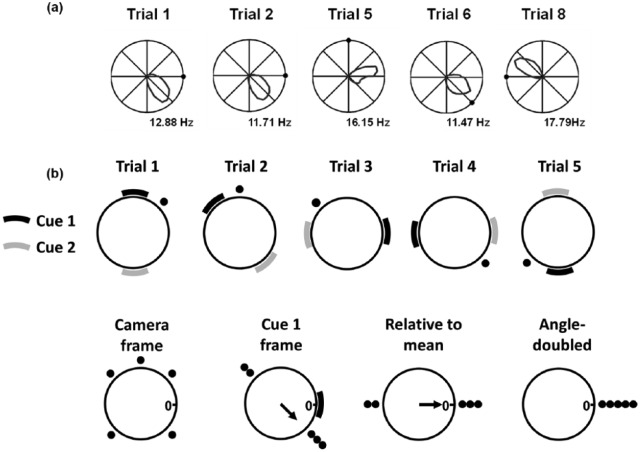
Tuning curve analysis. (a) Example of the tuning curve derived from a
single PoS HD neuron in a series of recording trials, selected from a
12-trial session. The plots show firing rate as a function of HD,
normalised to the peak rate (shown). (b) Schematic from a hypothetical
set of trials showing how data were transformed into a common reference
frame to allow population comparisons. The original reference frame was
that of the room-fixed camera: the top row shows an idealised trial in
which the cell consistently rotated its firing with the cue pair, but
was aligned relative to Cue 1 on trials 1, 2 and 5 and 180° away from it
on trials 3 and 4. The bottom row shows these data expressed in the
different reference frames: in the camera frame, the firing direction is
scattered; relative to Cue 1, it is bipolar with three trials in one
direction and two in the opposing direction; relative to the session
mean (arrow), the bulk of the firing is now aligned to zero, and after
angle-doubling the bipolar distribution is now transformed to
unipolar.